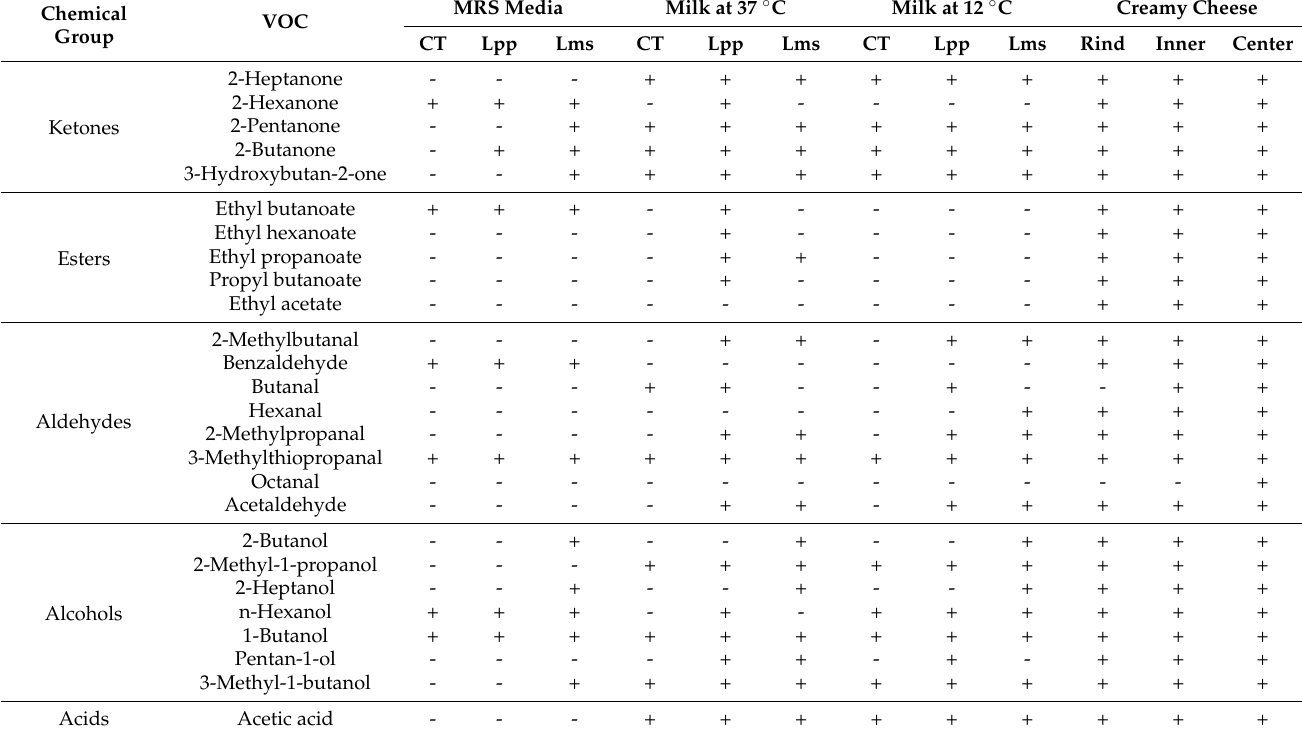
Table 2. VOCs detected in LAB cultures and creamy raw sheep milk